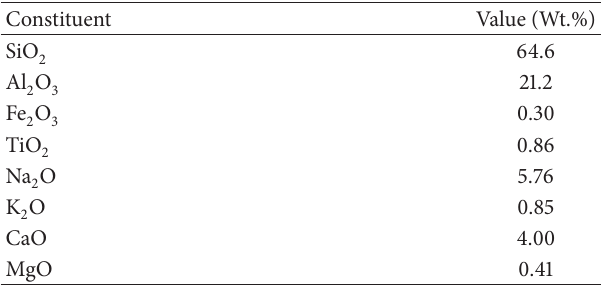
Table 4: Chemical analysis of